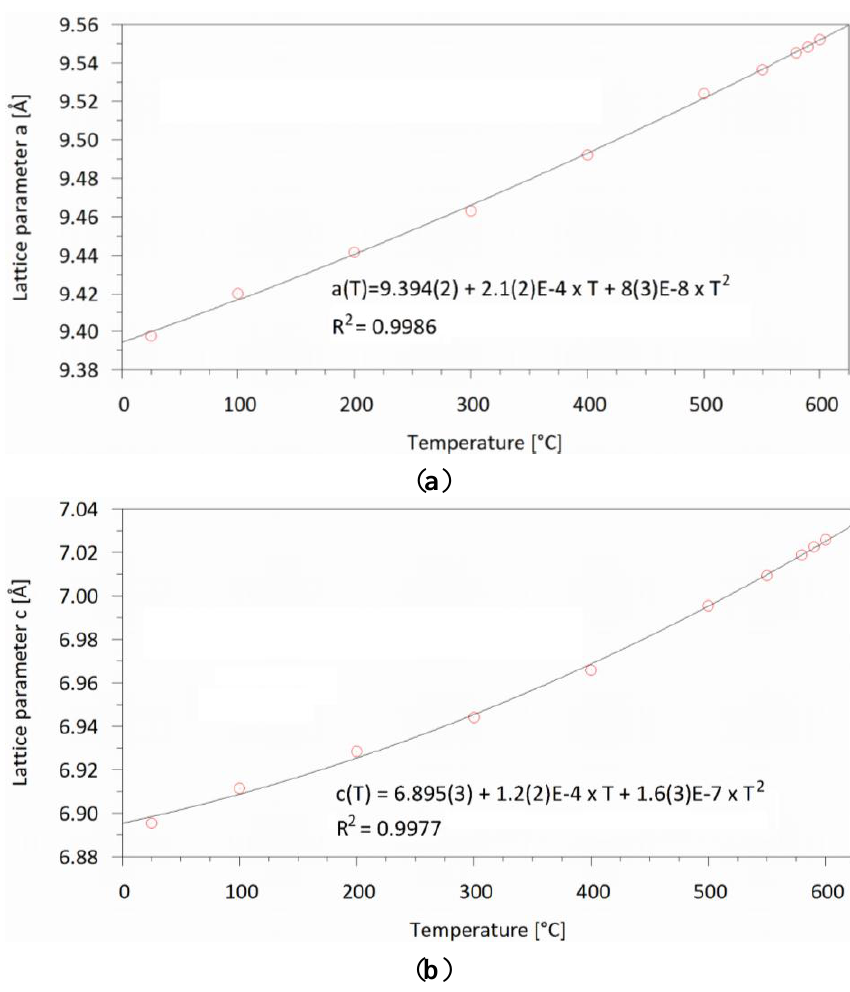
Figure 1. Evolution of the ( a ) a -; and ( b ) c -lattice parameters for hexagonal Na 2 Ca 3 (SO 4 ) 3